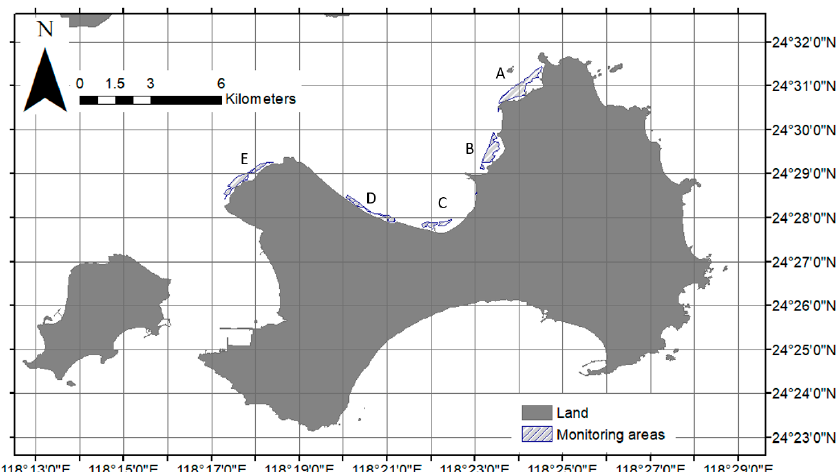
Figure 11. Monitoring areas used to detect changes in coastline conditions using NDWI as a surro- gate.